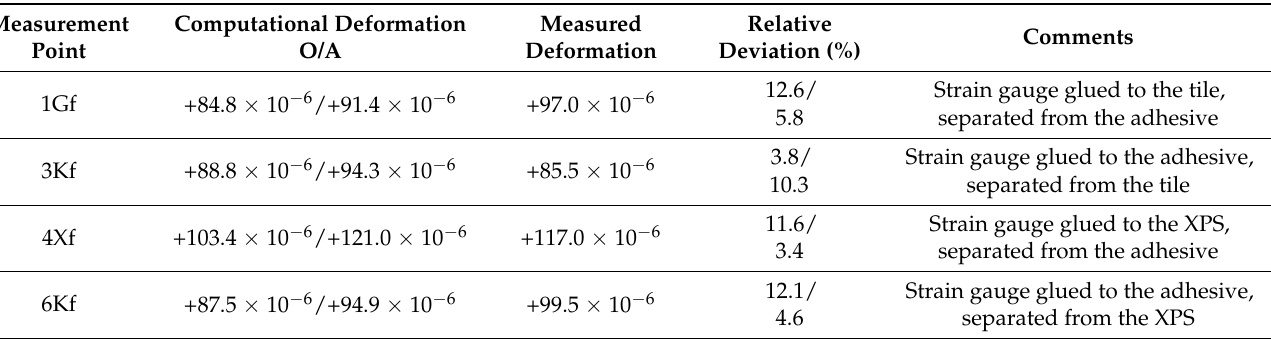
Figure 26. The diagram of horizontal deformations ε x in the II–II section. Table 2. The list of model